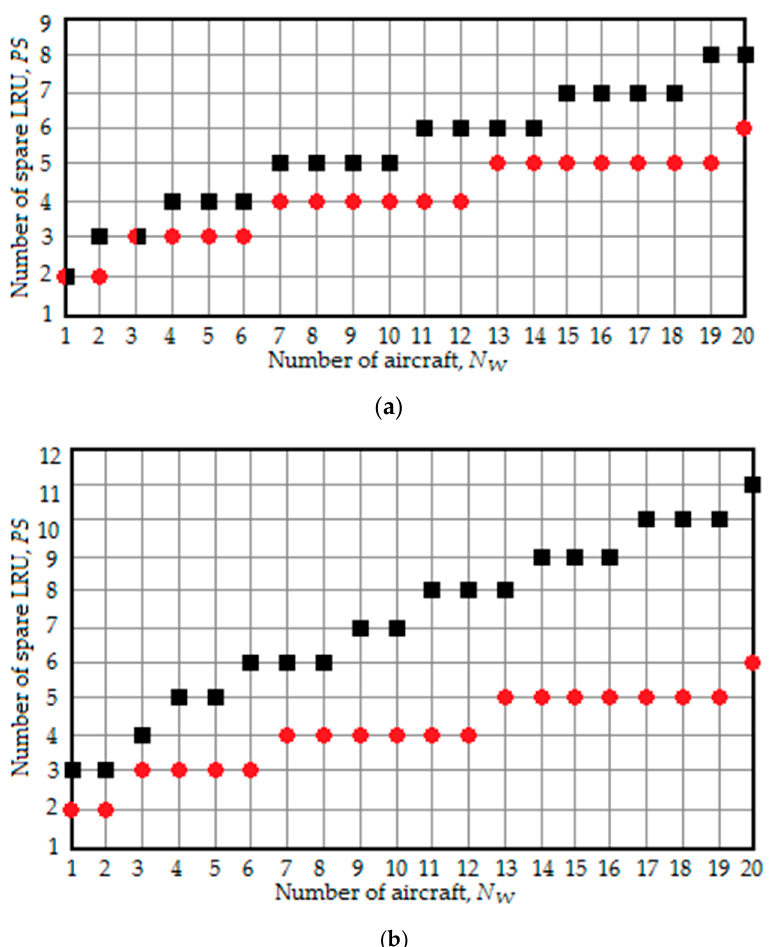
Figure 4. The dependency of the optimal quantity of spare LRU versus the quantity of aircraft for the first WM option; ( a ) Red circles: 𝑃 (cid:3033)(cid:3039)(cid:3036)(cid:3034)(cid:3035)(cid:3047)(cid:3007)(cid:3017) = 1 × 10 (cid:2879)(cid:2872) , black squares: 𝑃 (cid:3033)(cid:3039)(cid:3036)(cid:3034)(cid:3035)(cid:3047)(cid:3007)(cid:3017) = 1 × 10 (cid:2879)(cid:2871) ; ( b ) Red circles: 𝜃 = 1 × 10 (cid:2879)(cid:2872) h (cid:2879)(cid:2869) , black squares: 𝜃 = 1 × 10 (cid:2879)(cid:2871) h (cid:2879)(cid:2869)